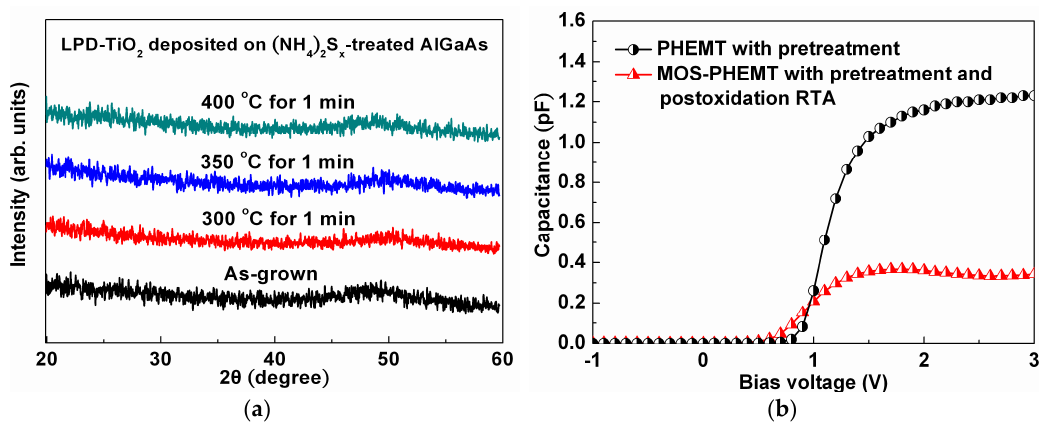
Figure 2. ( a ) XRD spectra of LPD-TiO 2 deposited on sulfide-pretreated AlGaAs with and without postoxidation RTA; ( b ) C-V comparison for sulfide-pretreated PHEMT and MOS-PHEMT with postoxidation RTA.